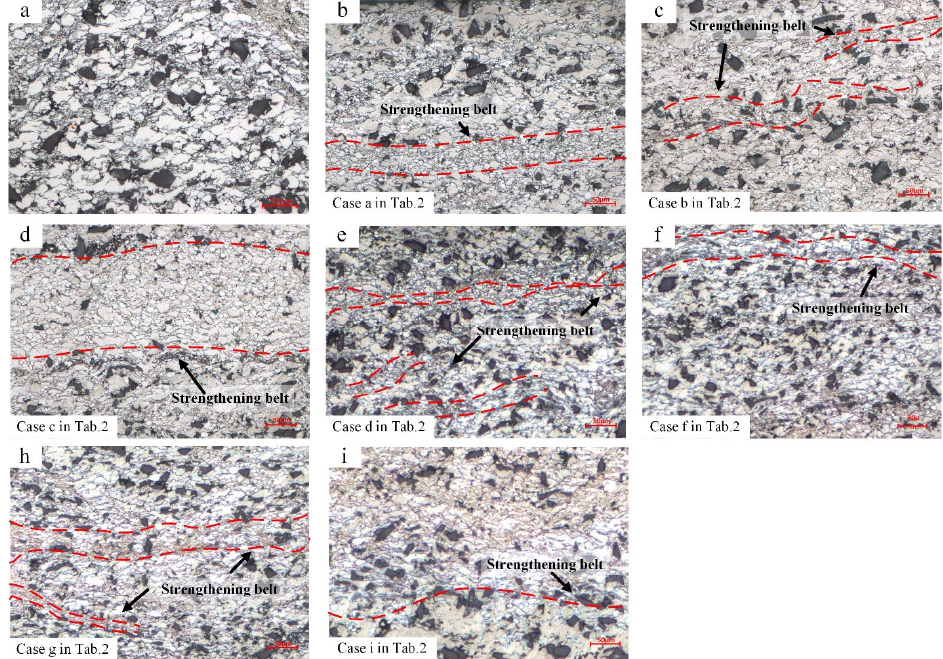
Figure 12. Experimental shot-peening-assisted cold-spraying micromorphology (polished and etched): ( a ) the original morphology; ( b – i ) the morphology after